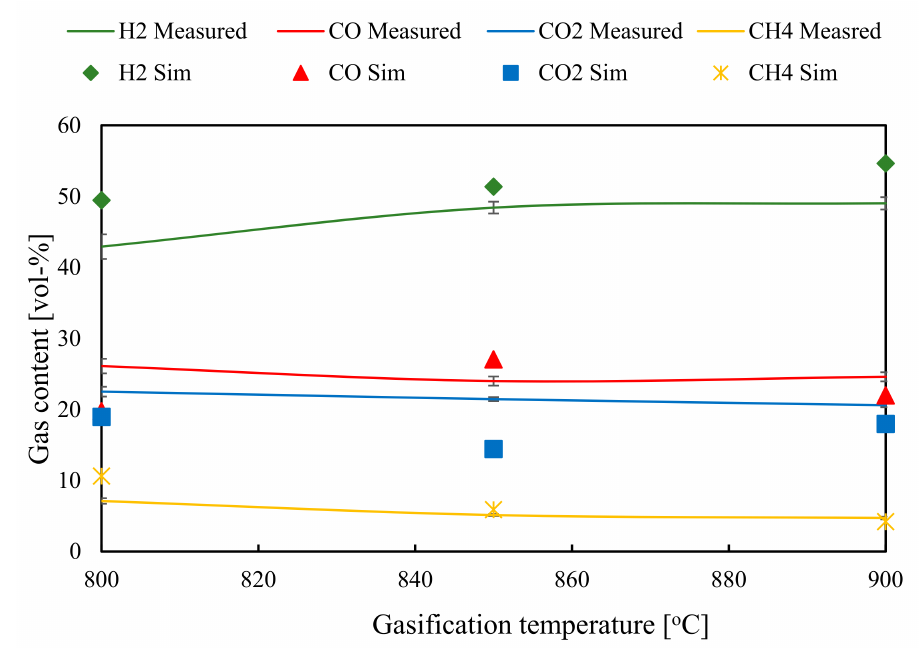
Figure 4. Effect of gasification temperature on the gas composition.